Question: Sum up the contents of this chart in one sentence.
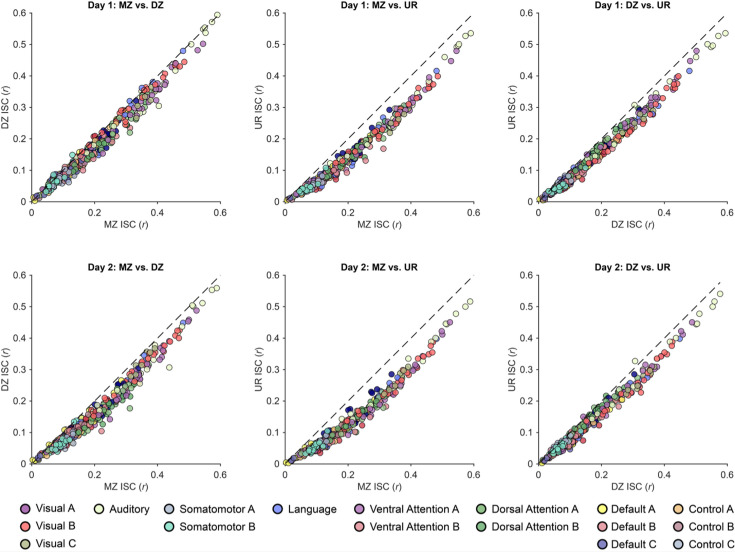
Answer: Blood oxygen level-dependent (BOLD) time course similarity scales with genetic relatedness across the cortex. ( A ) Group differences in average BOLD time course similarity (indexed by intersubject correlation, ISC) show that BOLD time course similarity is greater among dyads who are more genetically related (51 MZ dyads, 34 DZ dyads, 690 UR dyads). Here, top and bottom rows reflect data acquired on different days of data collection while subjects viewed largely non-overlapping sets of movie clips. ( B ) Group-average ISC values used to create the difference maps in A, plotted in order of average ISC across all subject pairs, show that group differences are most pronounced in parcels with medium to high ISC (shading = SEM).